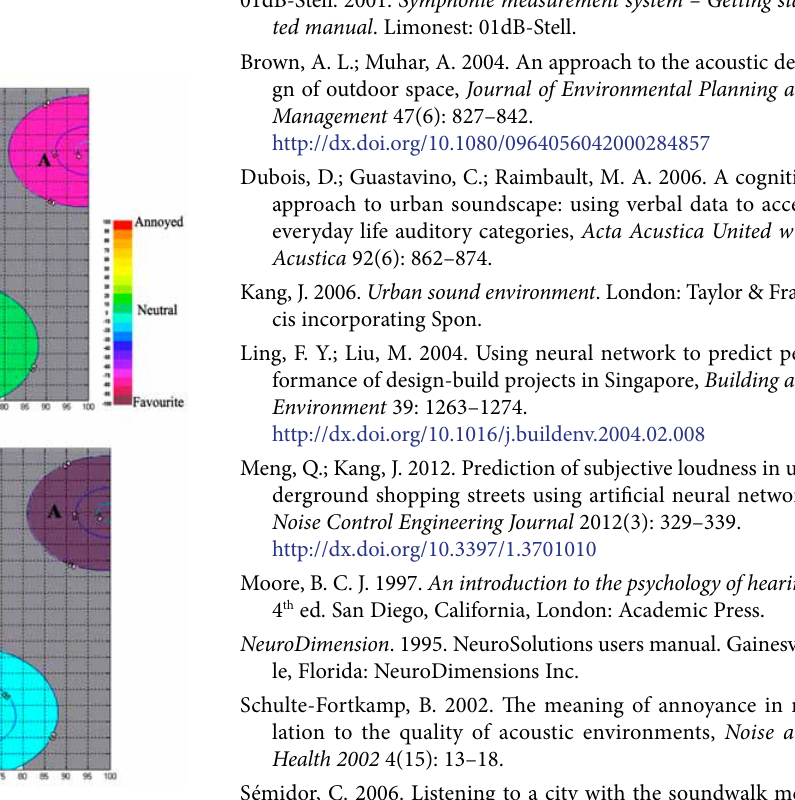
Fig. 10. Sound preference evaluation maps in terms of ‘favourite’ for (a) 18–24 age group; (b) 55–64 age